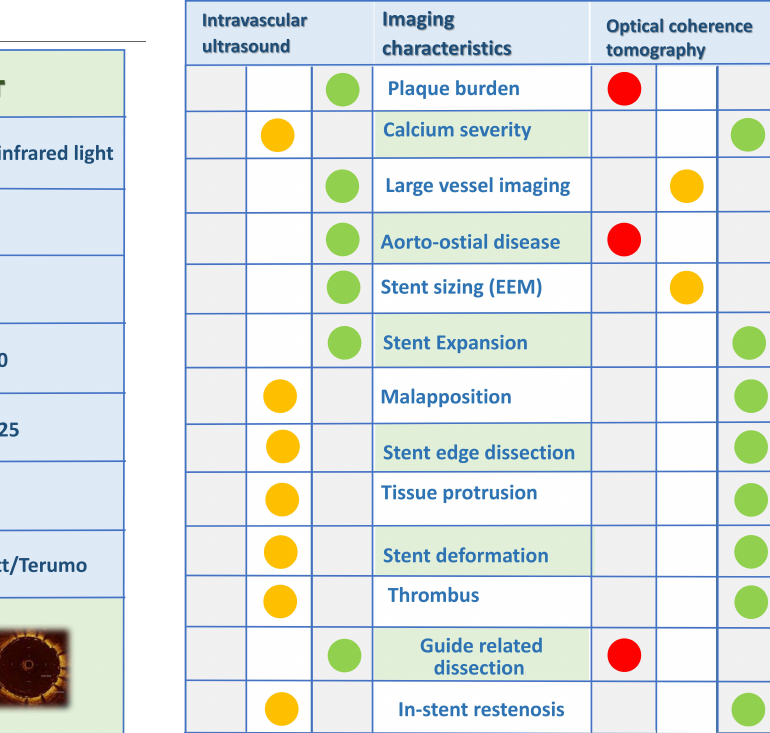
TABLE 2 | Intra-coronary imaging device